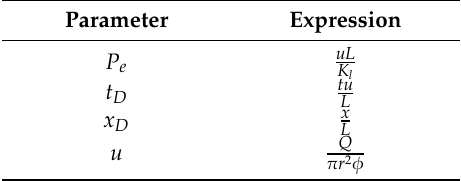
Table 3. Dimensionless parameters.